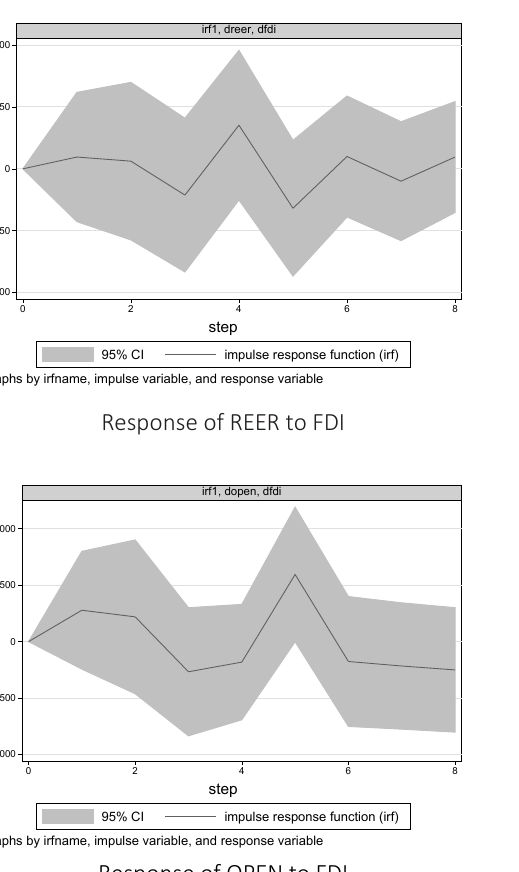
Response of GROWTH